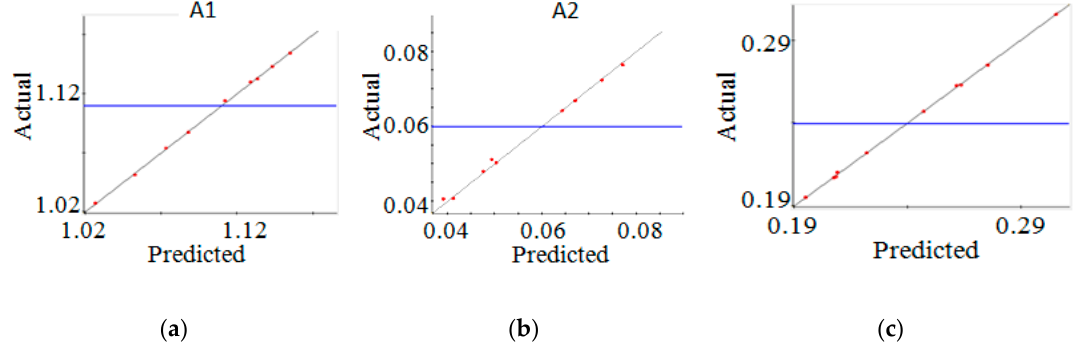
Figure 15. Comparison between calculated results and approximate model with the misalignment-rubbing coupling fault. ( a ) fundamental frequency; ( b ) 2× fundamental frequency; ( c ) 3× fundamental frequency.